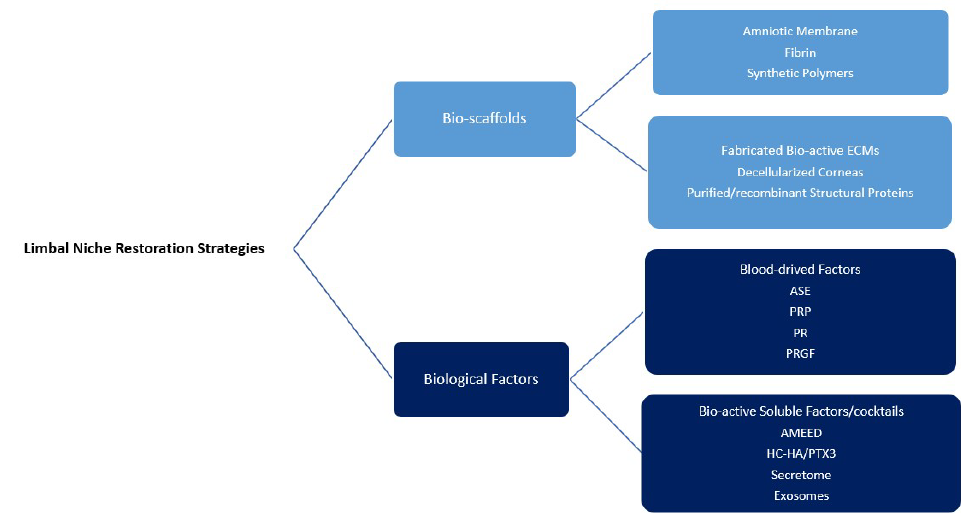
Figure 3. Different strategies and materials available for limbal niche restoration (ECM: extracellular matrix, ASE: autologous/allogeneic serum eye drops, PRP: platelet-rich plasma, PR: platelet releasate, PRGF: plasma rich in growth factors, AMEED: amniotic membrane extract eye drop).